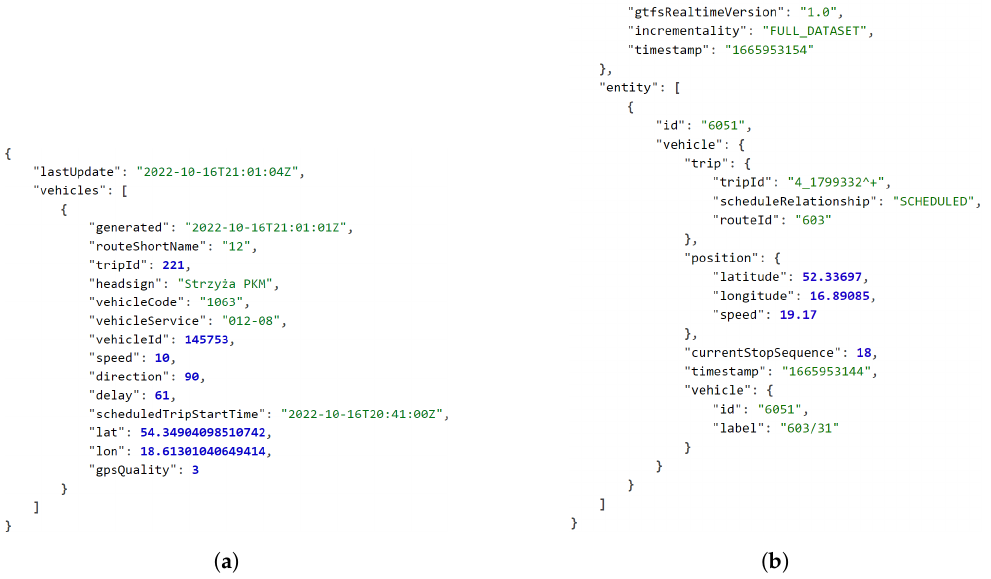
Figure 3. Samples of public transport vehicles data in two Polish cities on 16 October 2022. ( a ) Tram in Gda´nsk [78]. ( b ) Bus in Pozna´n [79].